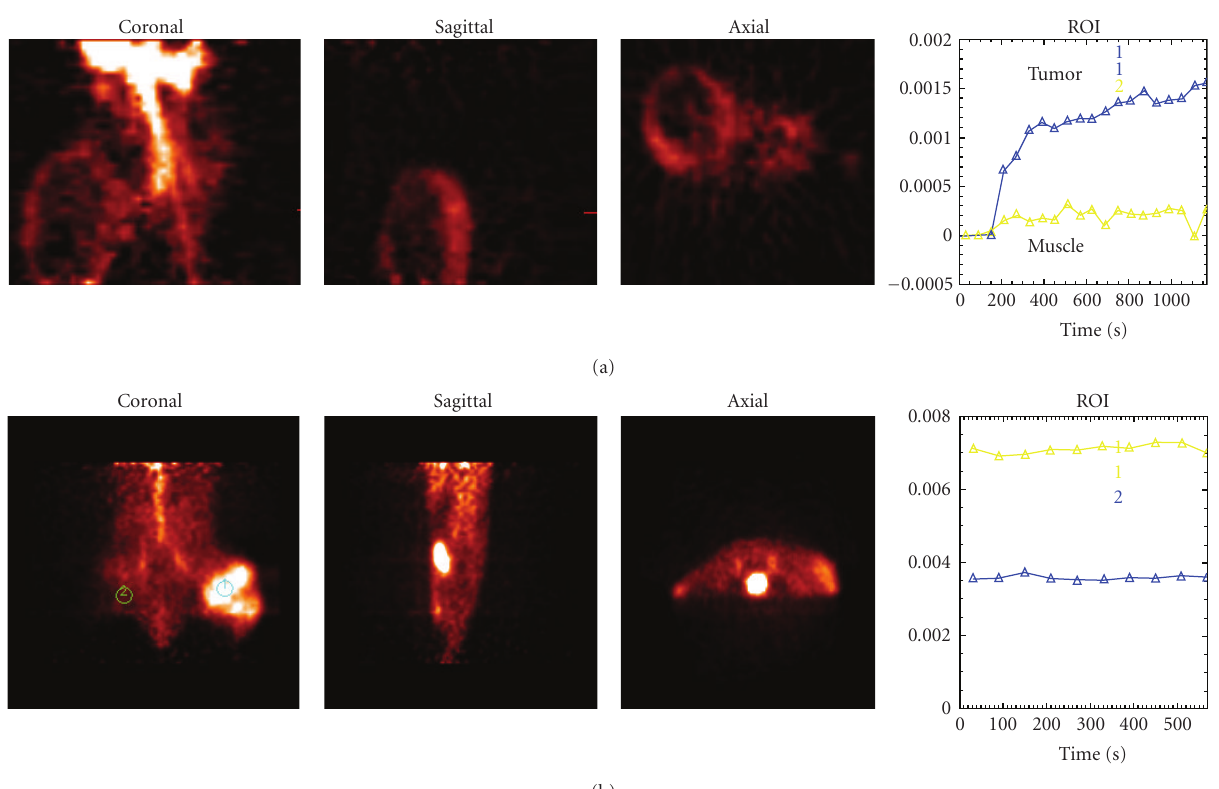
Figure 5: Dynamic mPET Imaging of 68 Ga-GP (a) and 18 F-FDG (b) in breast tumor bearing rats (0.003mg, 600uCi/rat, iv) at 0–20 min showed tumor could be visualized by both compounds.